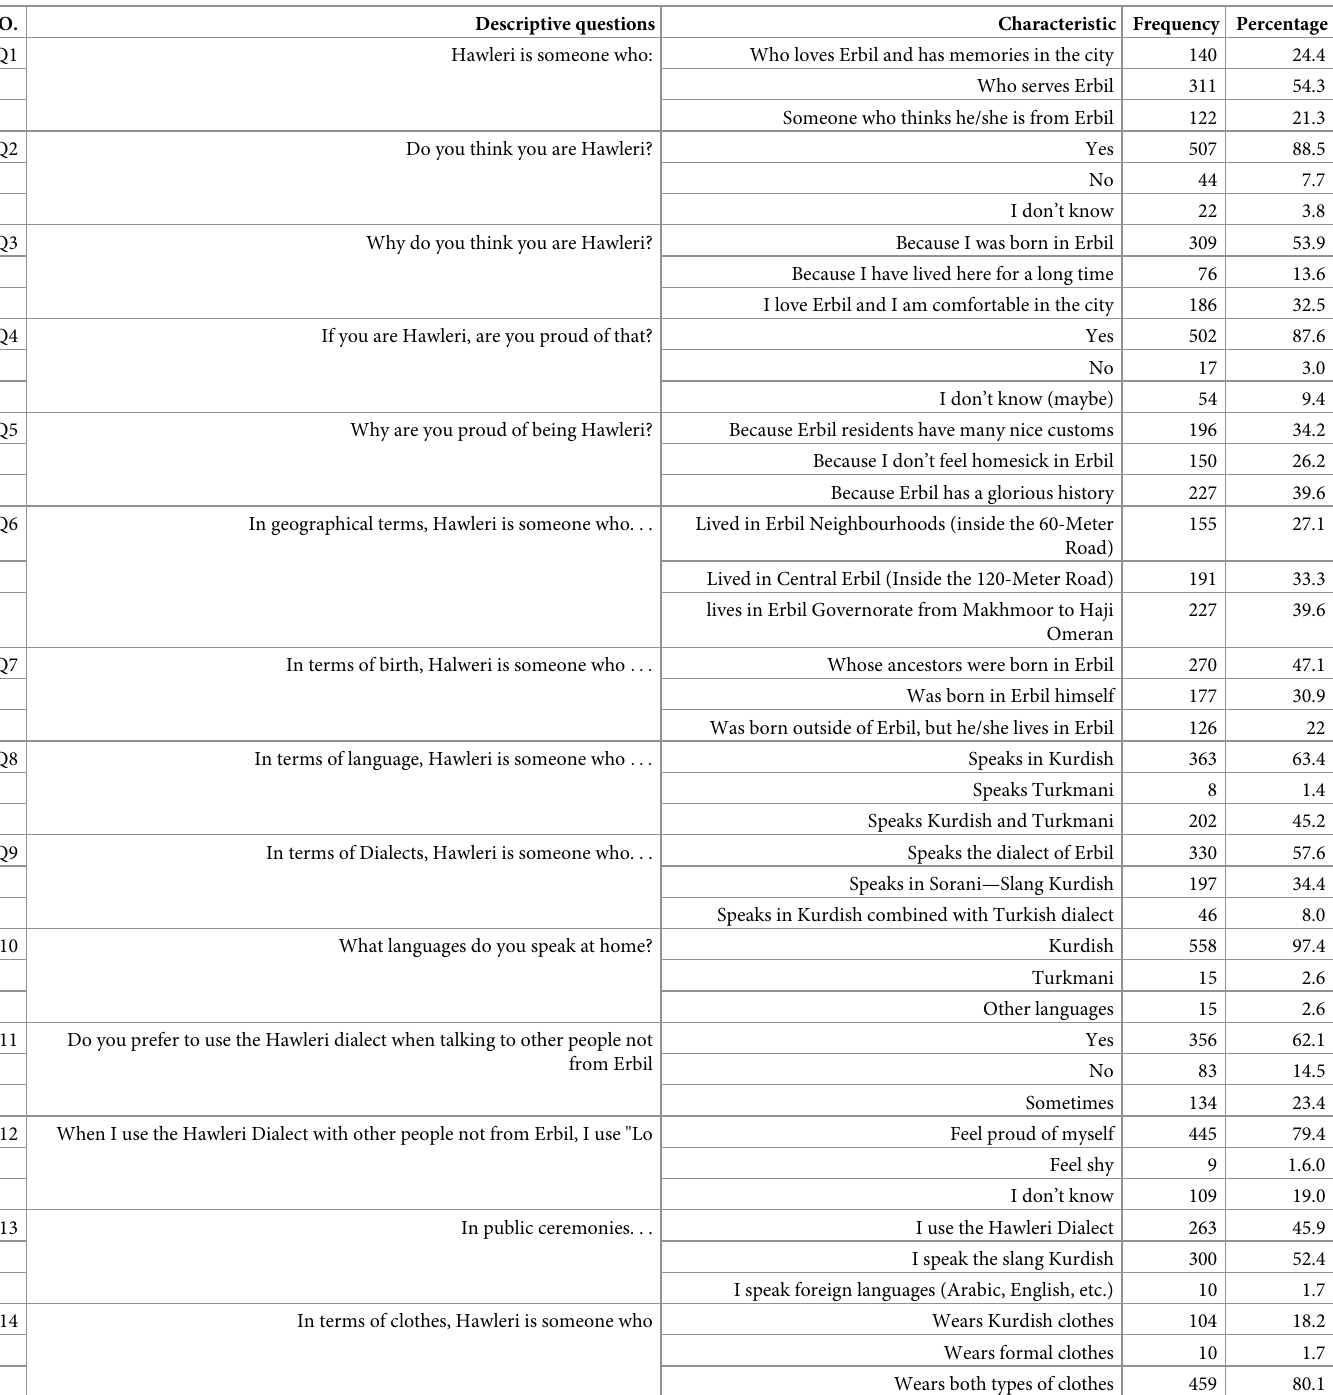
Table 2. Halweri